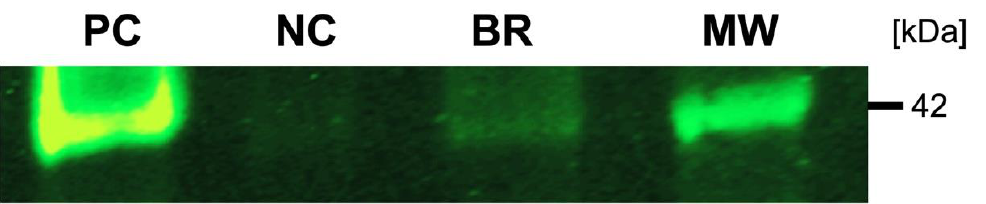
Figure 4. Marker protein analysis using Western blot. α -SMA cell-seeded scaffold cultured for two weeks in the presence of a bioreactor (BM) and in the absence of a bioreactor as a negative control (NG), murine blood vessels as a positive control (PC) and marker lane (MW).